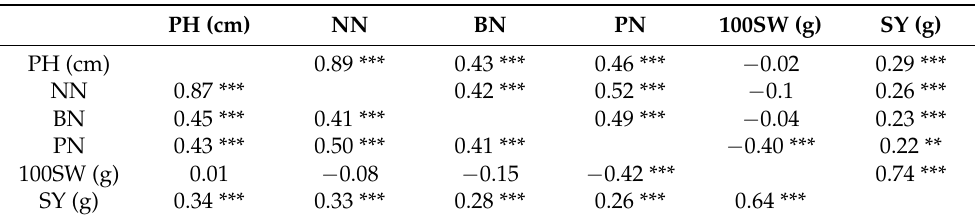
Table 2. Correlation coefficients between the six soybean P-efficiency-related traits at maturity under NP and LP conditions.